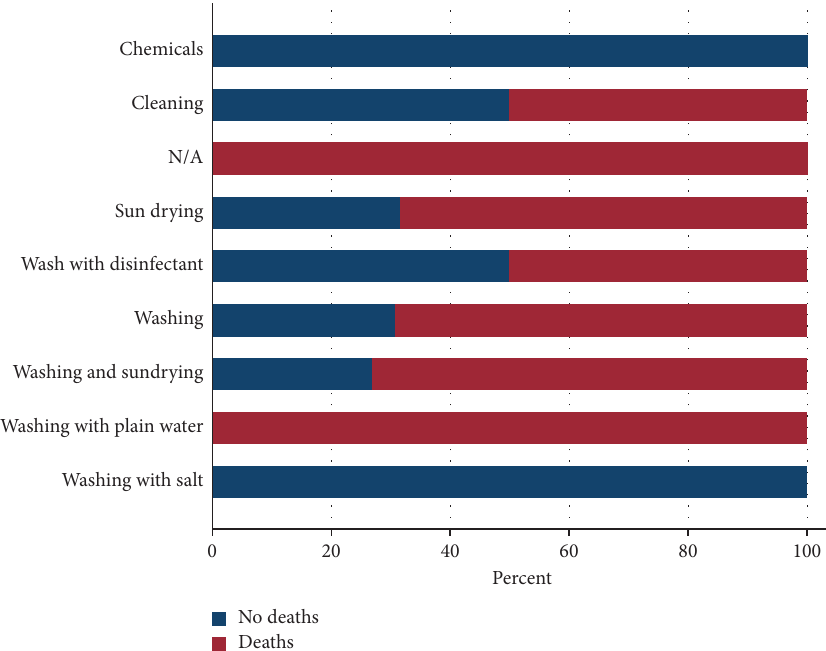
Figure 7: Deaths (percentage, x -axis) reported in farms using different methods of net disinfection after harvesting. Most deaths (100%) were recorded in farms using plain water to clean nets, while there were no deaths when chemicals and salt were